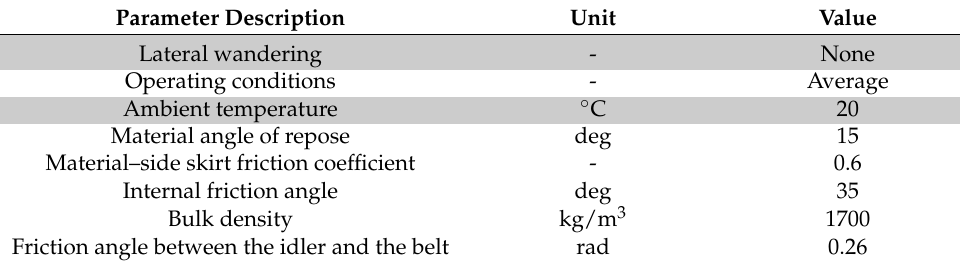
Table 8. Operating